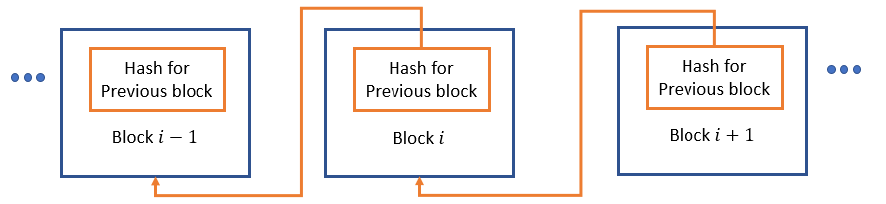
Figure 2. Structure of a blockchain demonstrating the dependency of each block on the previous